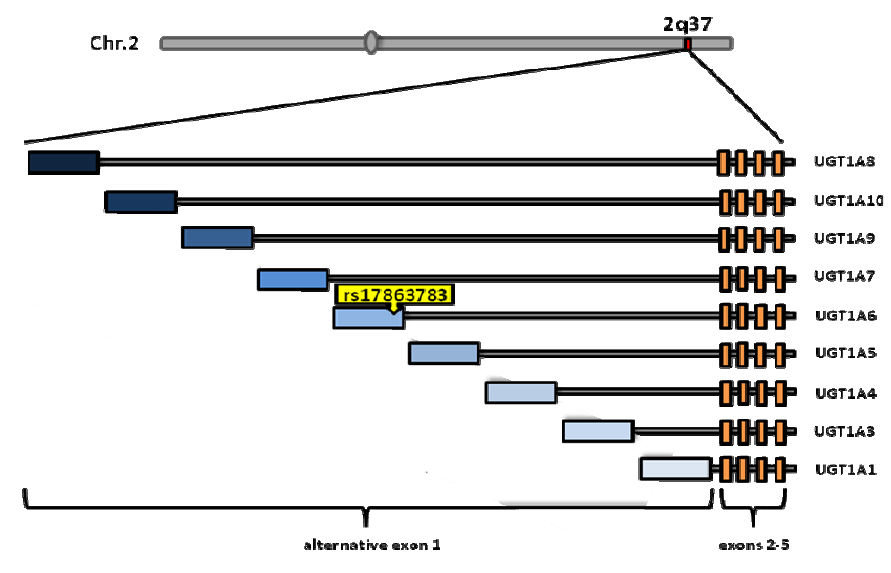
Figure 2. UGT1A locus and location of the functional UBC